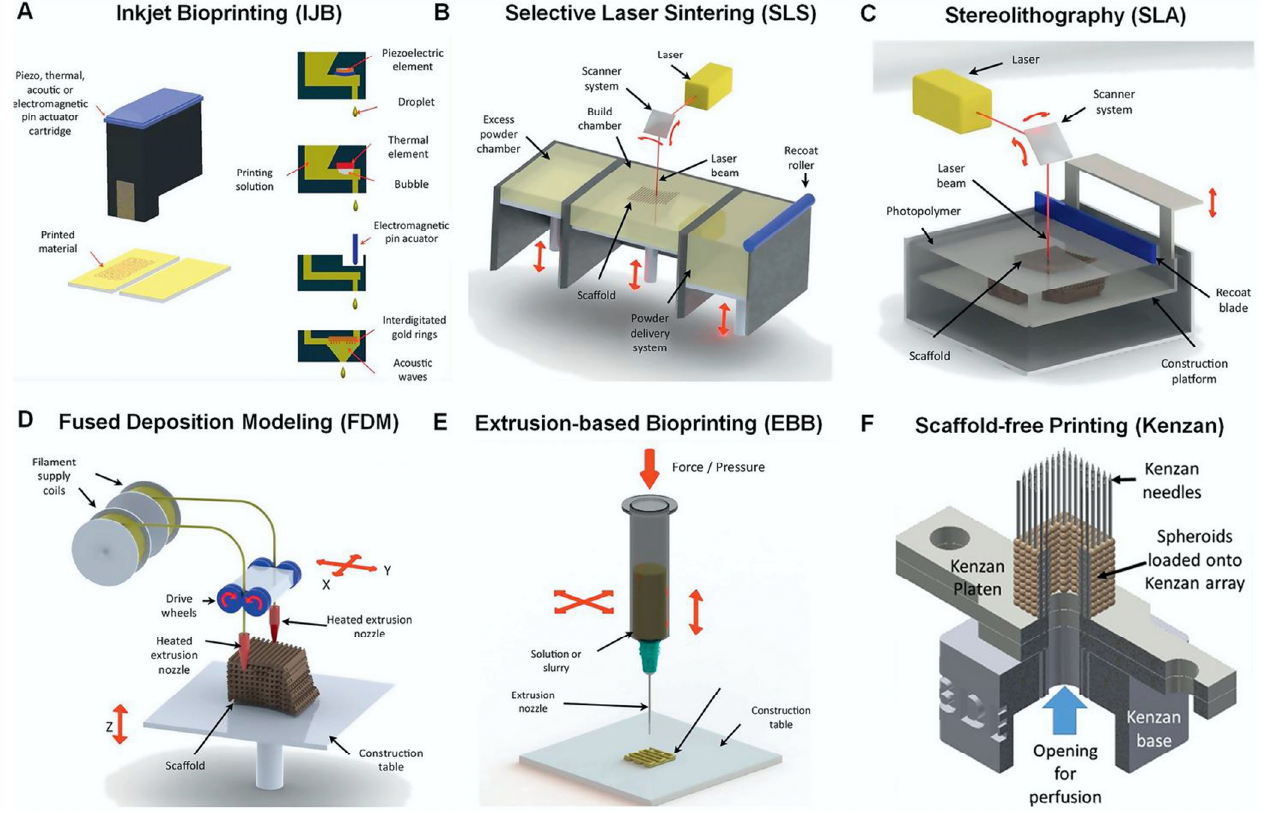
Figure 9. Commonly used bioprinting technologies